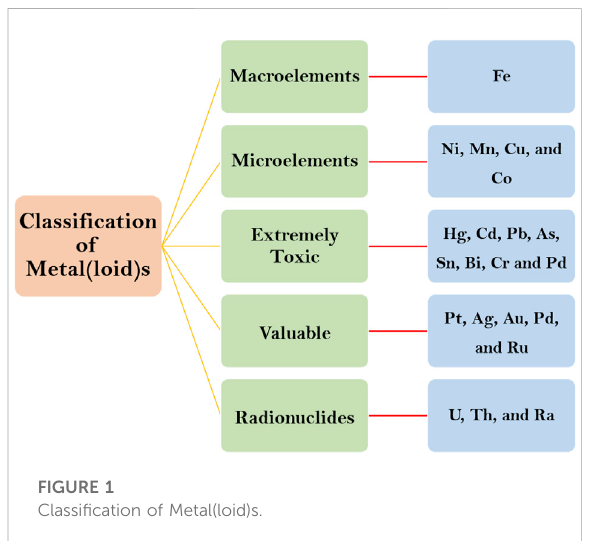
FIGURE 1 Classi fi cation of Metal(loid)s.